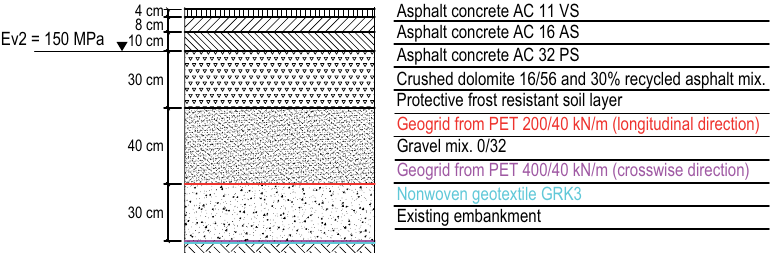
Figure 4. Road structure No.